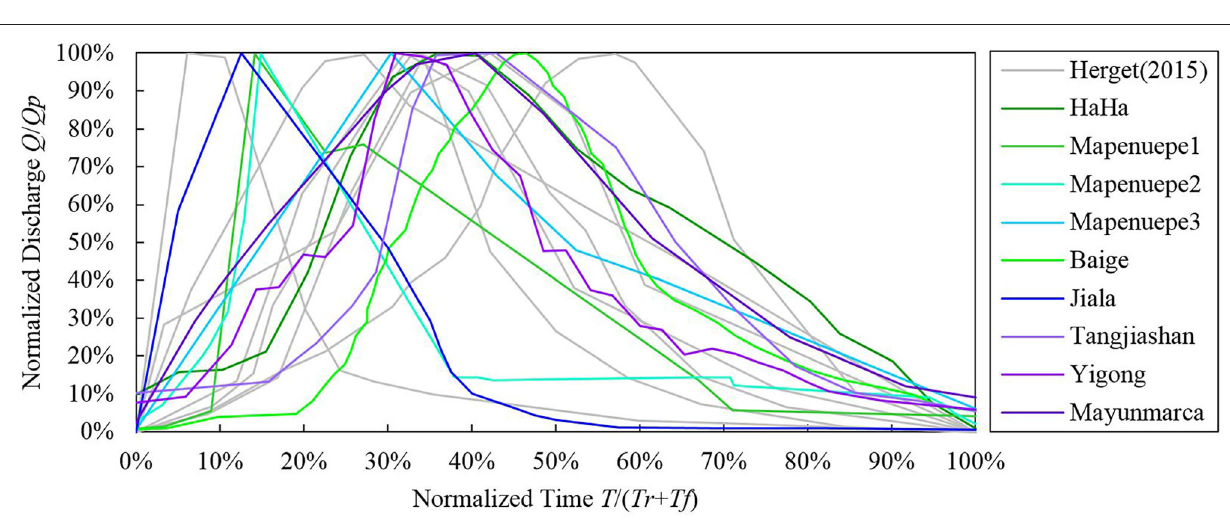
FIGURE 9 | Normalized hydrographs of landslide (moraine) dams’ breach